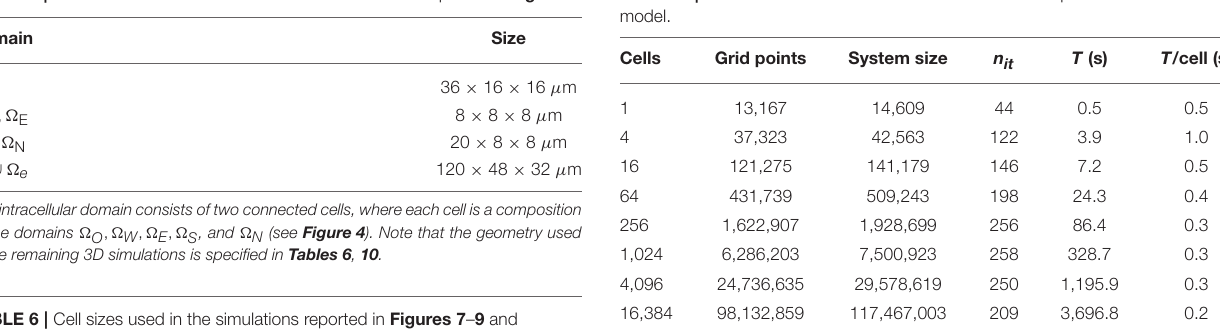
TABLE 5 | The cell and domain sizes used in the simulations reported in Figure 5 .